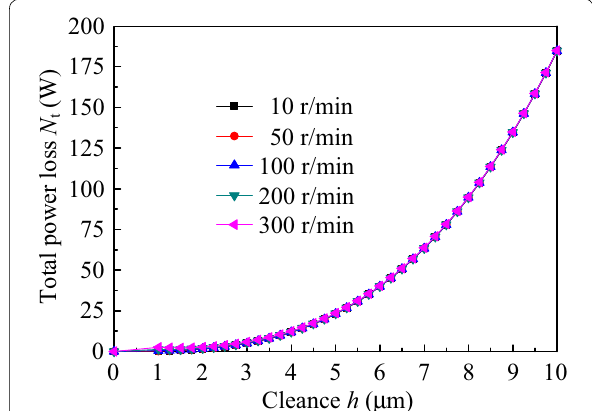
Figure 4 Change of friction power loss with clearance